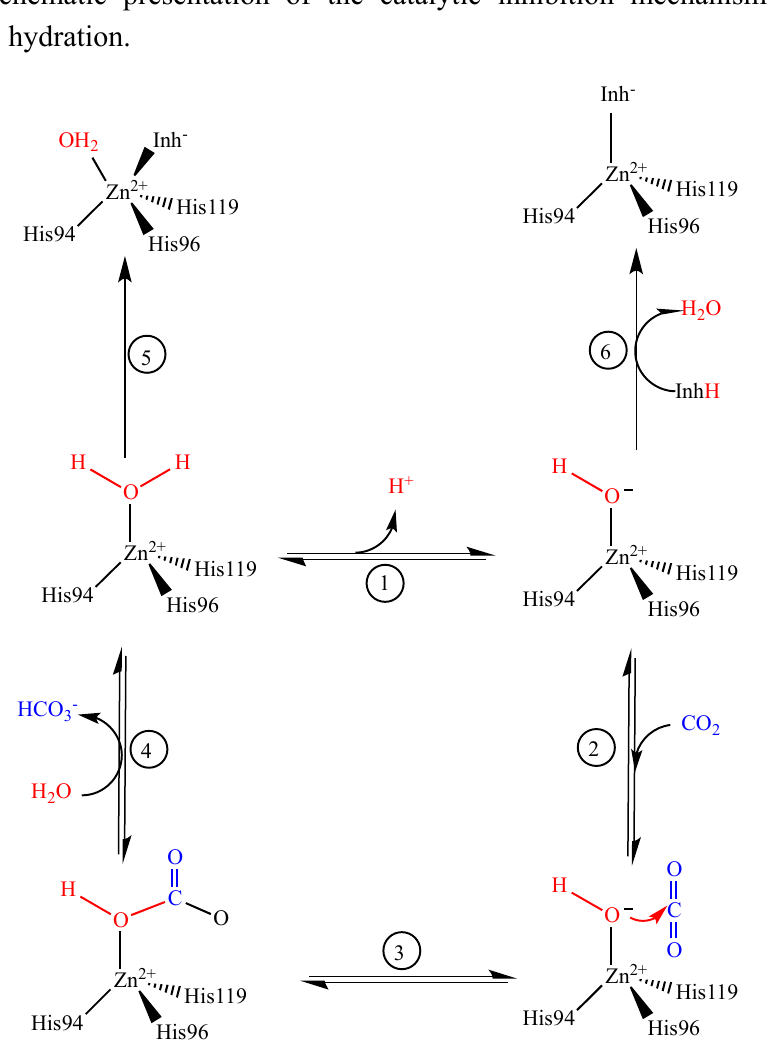
Scheme 1. Schematic presentation of the catalytic inhibition mechanism for the